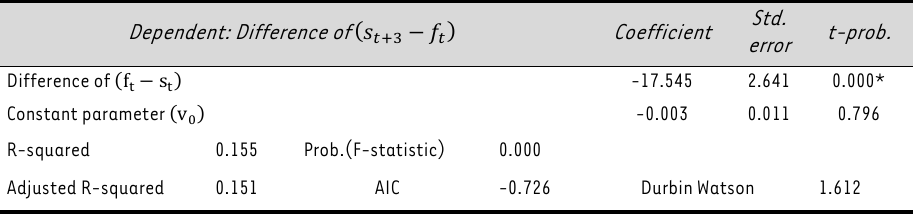
The forward premium hypothesis (OLS) – first differenced approach